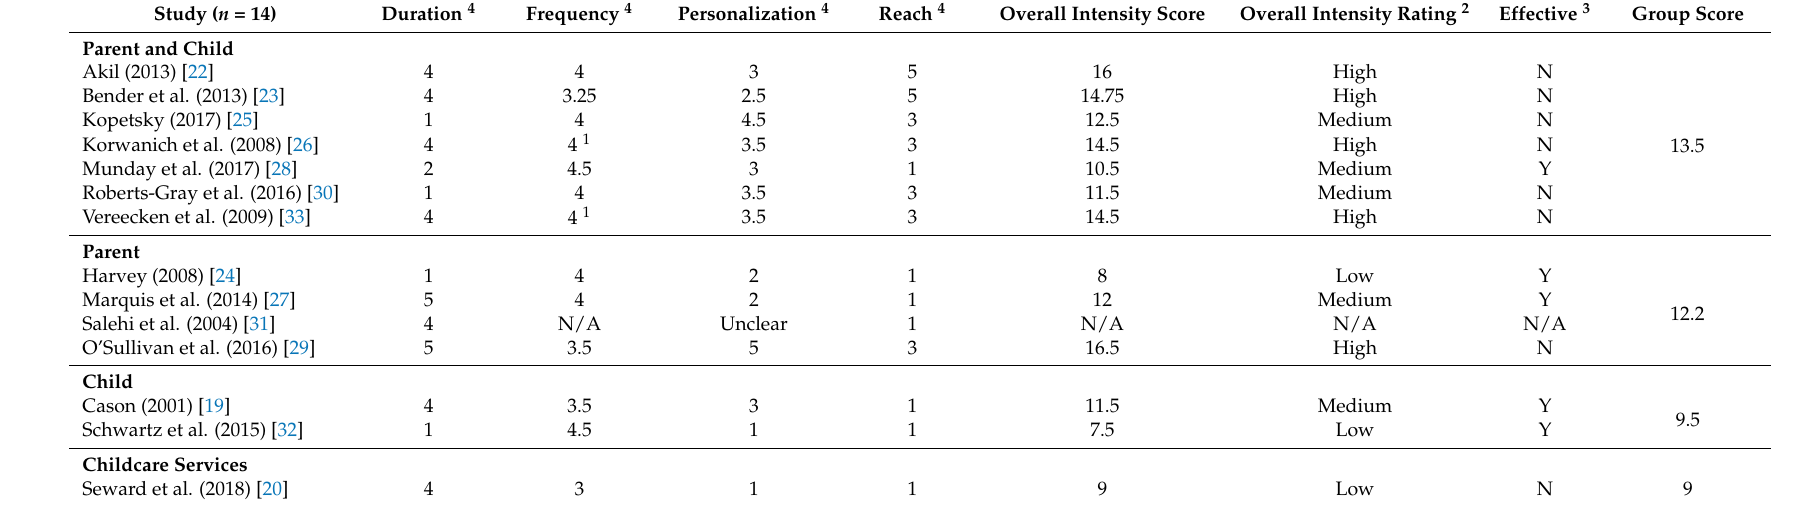
Table 3. Summary of overall intervention intensity